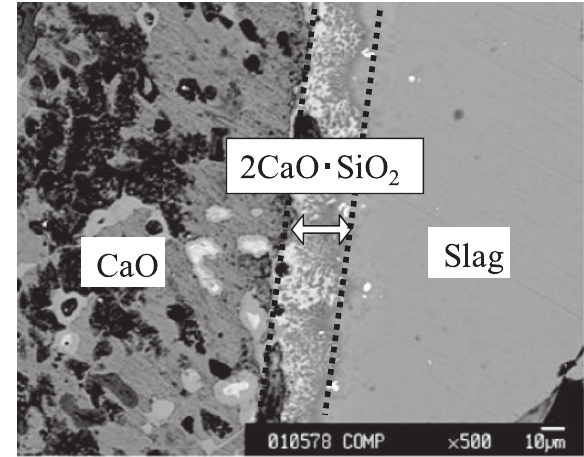
Fig. 9: Increment of CaO content when 3.5 g of sintered lime (s-Lime) and 3.5 g of preheated metallurgical lime (p-Lime) dissolved into 100 g of FeO-CaO-B O slag, respectively. 2 3